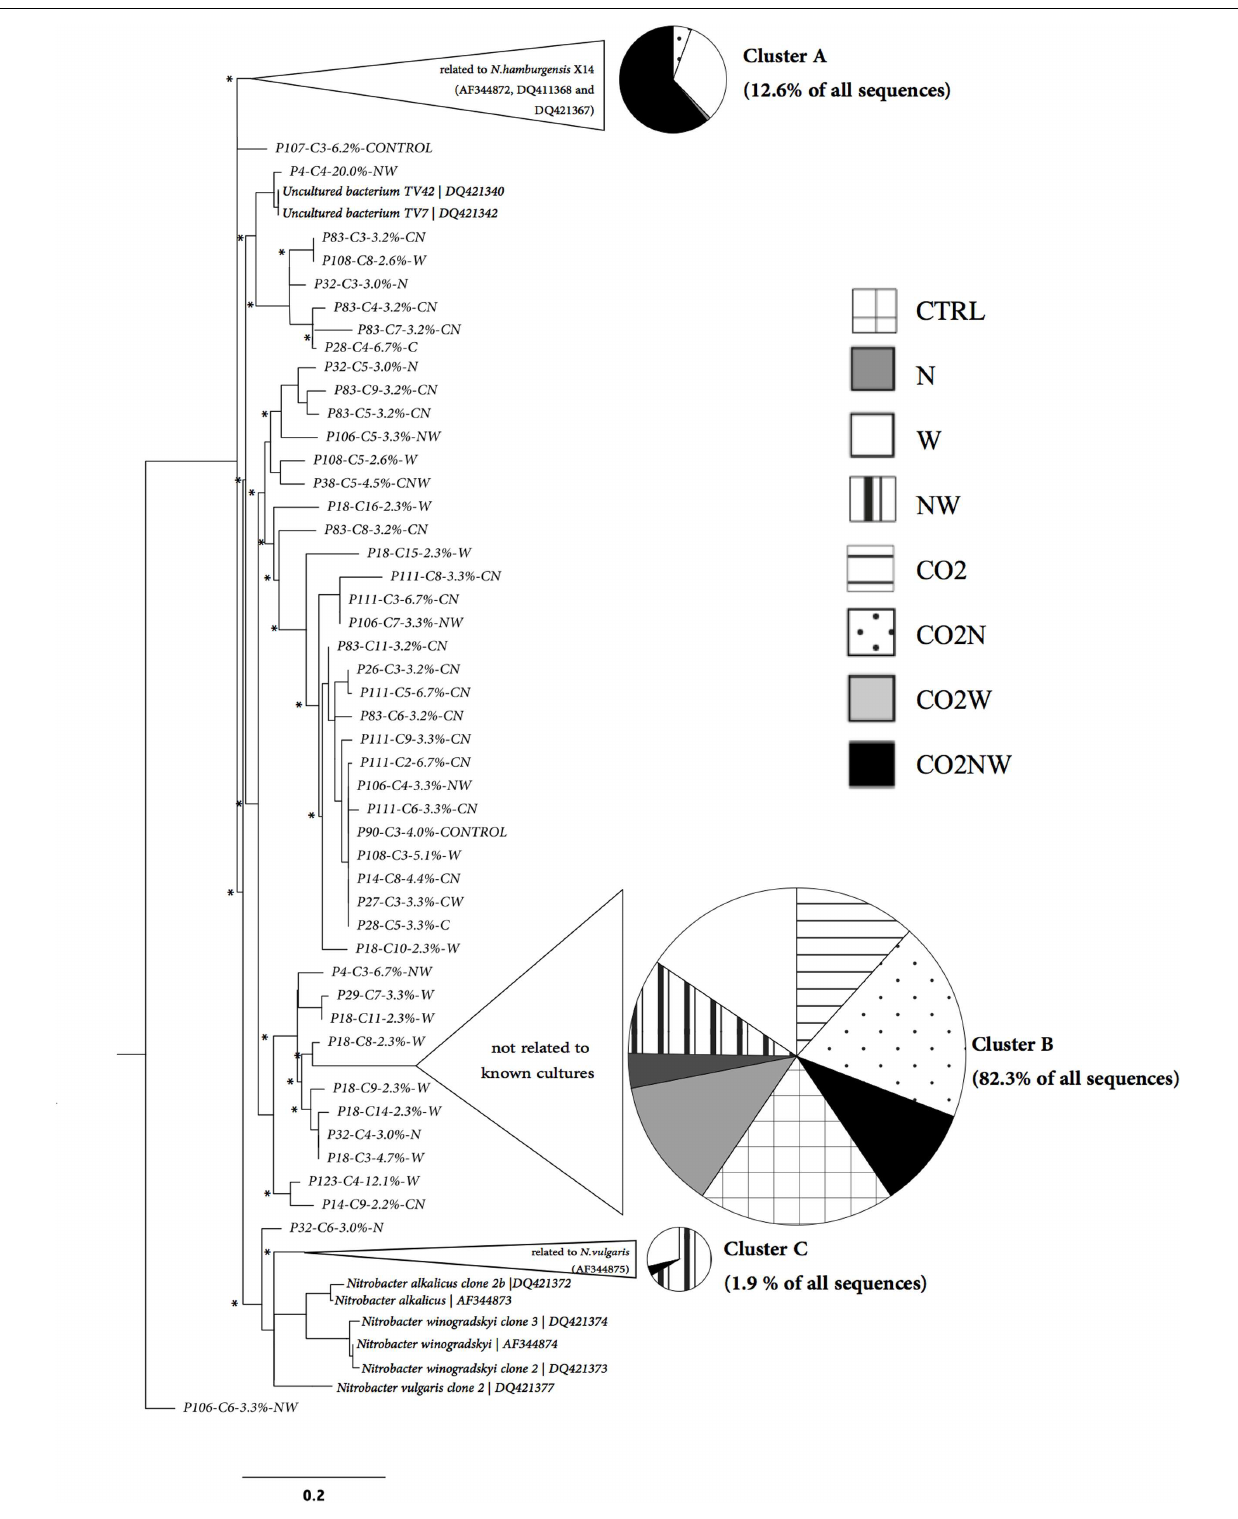
Frontiers in Microbiology |